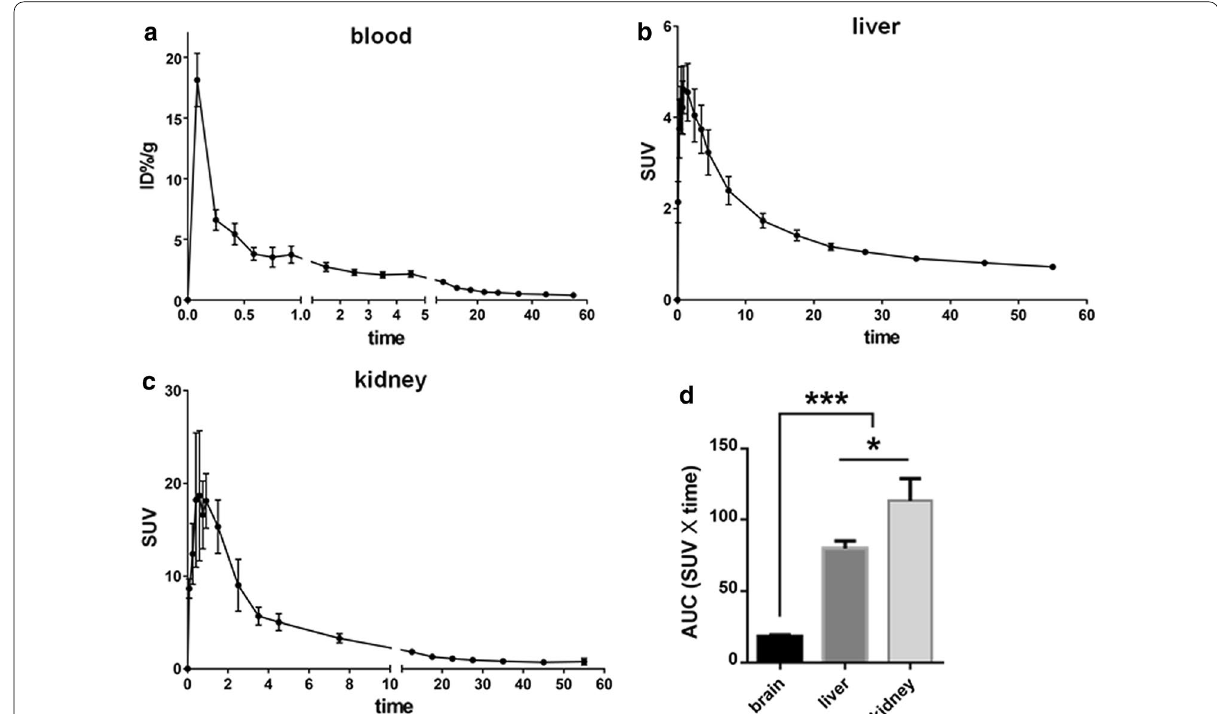
Fig. 4 Studies of pharmacokinetics and metabolic kinetics of 18 F-deoxy-thiamine in ICR mice. a The TAC of 18 F-deoxy-thiamine in blood (radioactivity expressed as IA%/g). b , c The TACs of 18 F-deoxy-thiamine in liver and kidney, respectively (radioactivity expressed as SUV). D. Comparisons of AUC values within 60 min between brain, liver, and kidney. Note that the scale of X axes in a , c was changed properly. * P < 0.05. *** P < 0.001. Repeated measurement of ANOVA with Tukey’s post hoc, n 5 for each =